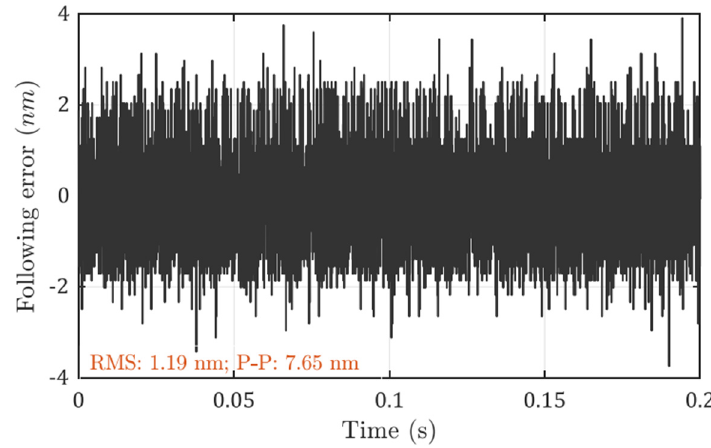
Figure 8. Measured following error with PID controller.